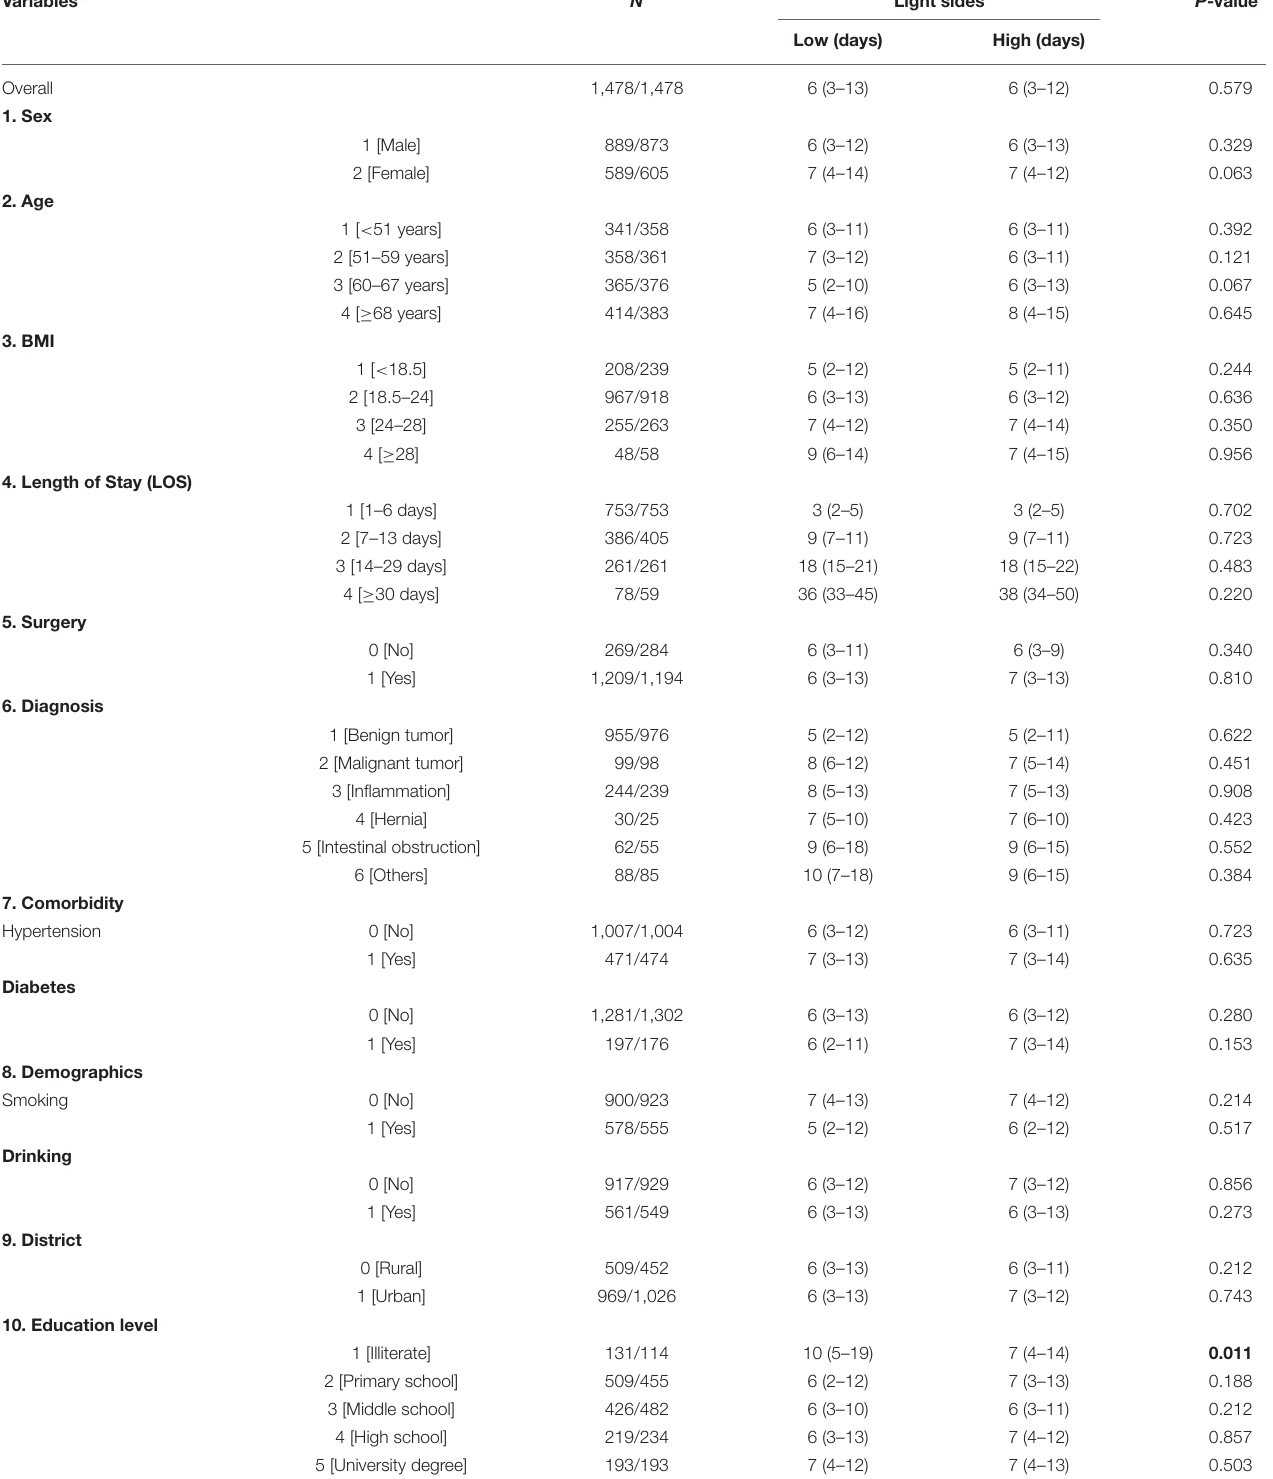
TABLE 3 | Length of stay (LOS) of patients by light sides of the hospital unit. Variables